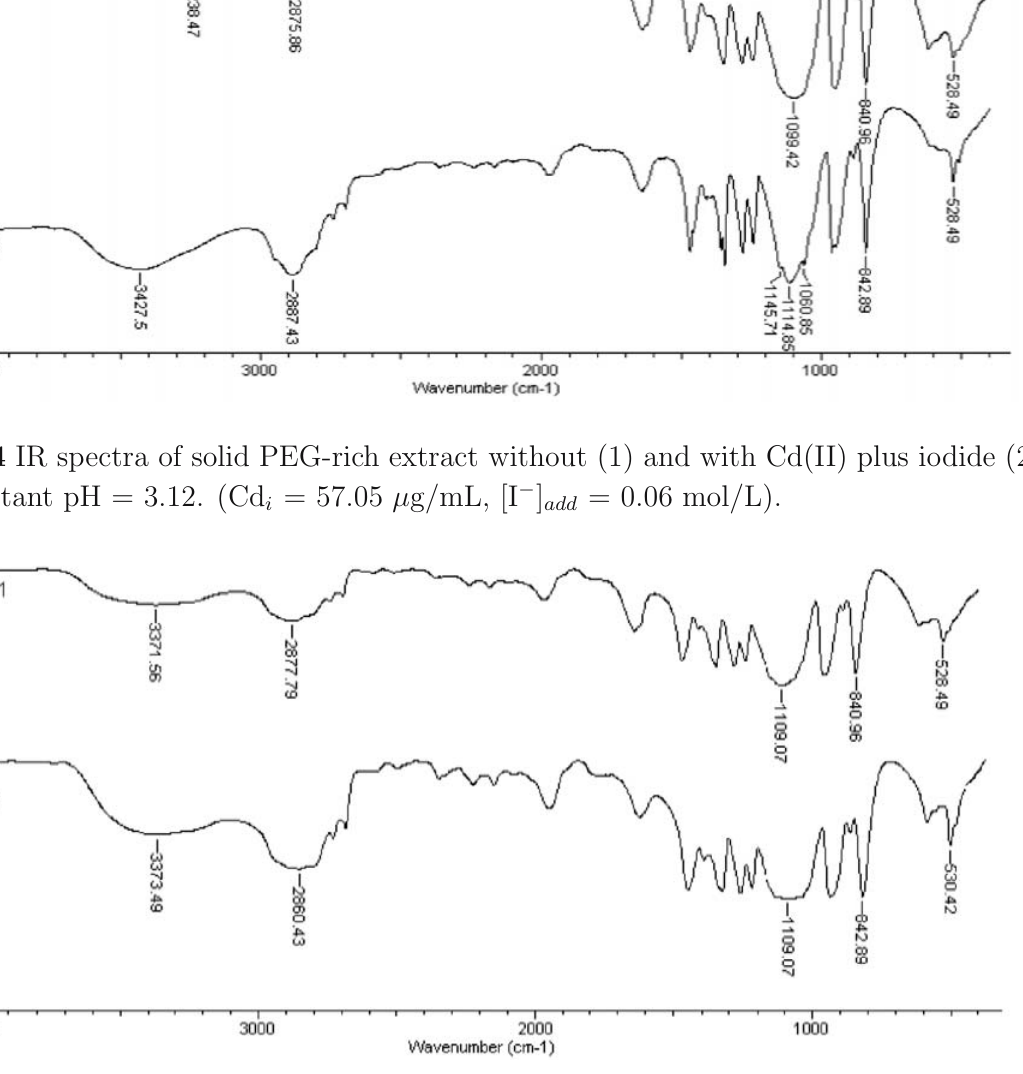
Fig. 5 IR spectra of solid PEG-rich extract without (1) and with Cd(II) plus iodide (2), extractant pH = 4.53. (Cd i = 57.05 µ g/mL, [I − ] add = 0.06